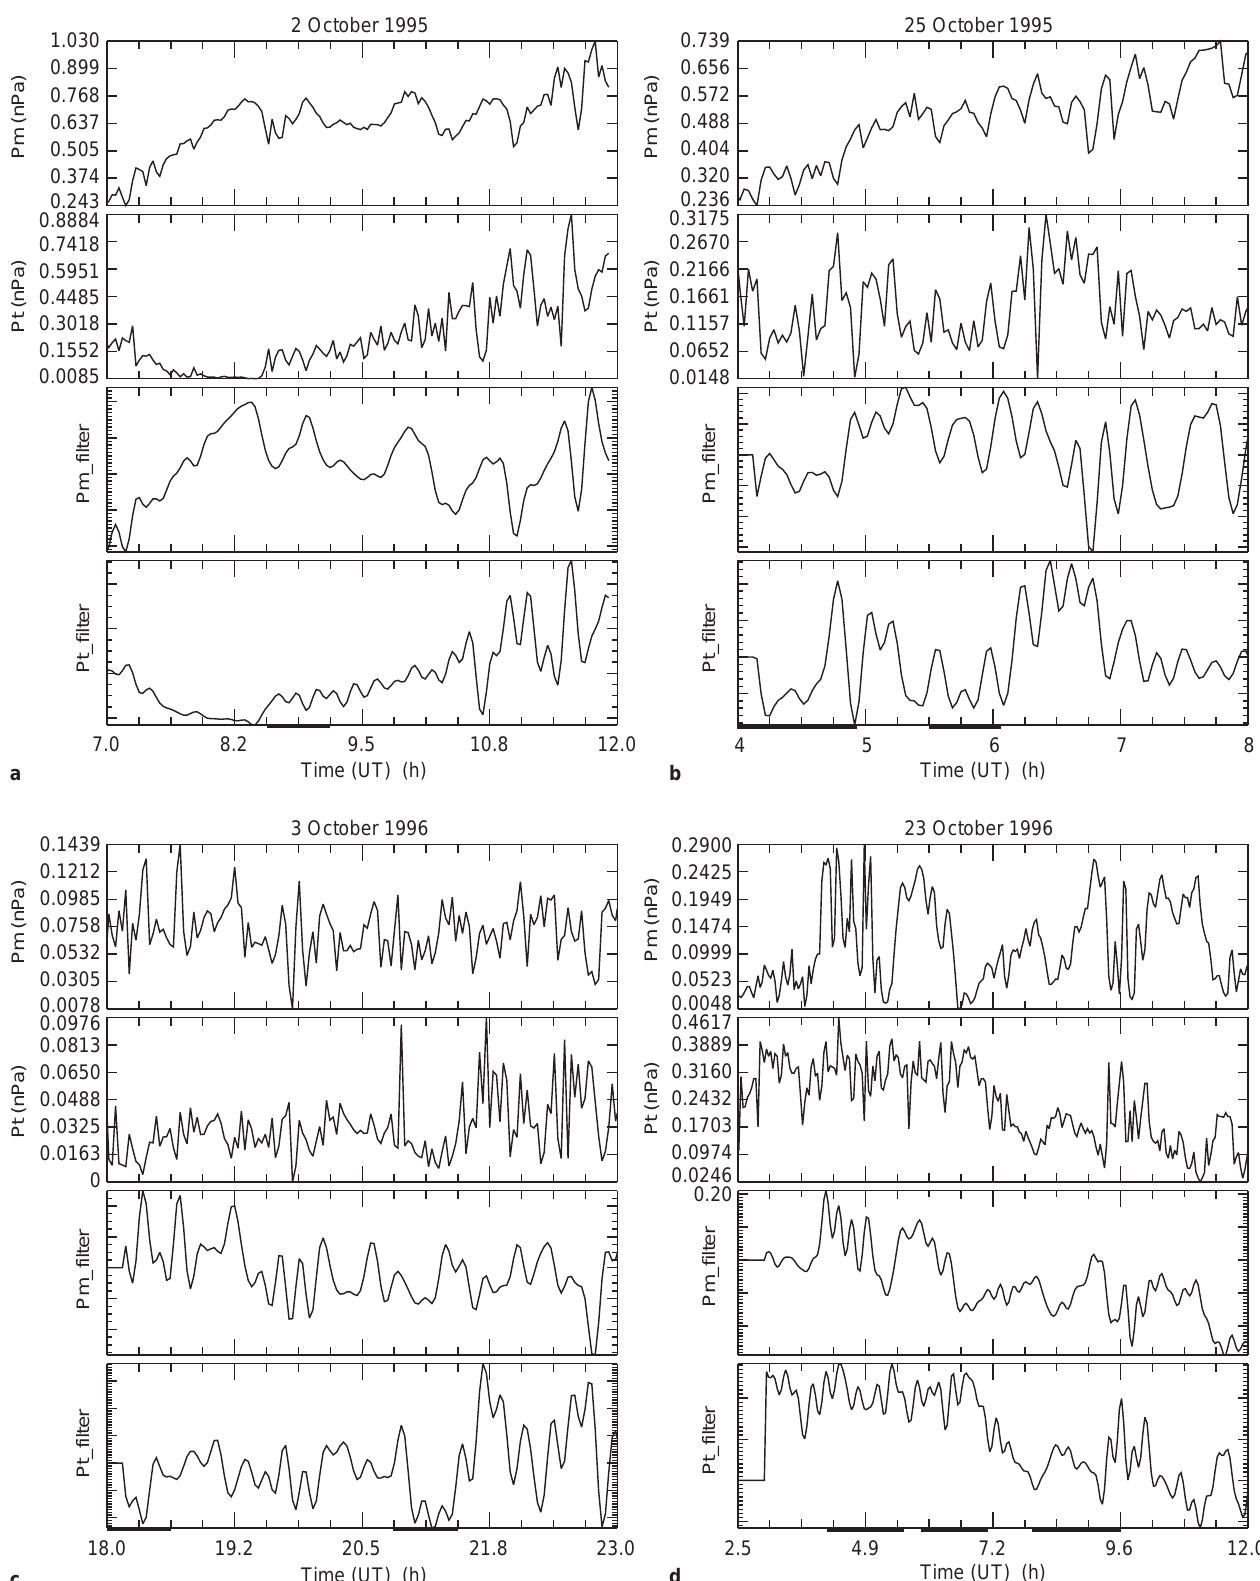
Fig. 2a–d. Magnetic pressure and plasma pressure ( upper panels ) are presented for the time intervals: a from 07:00 UT to 12:00 UT 2 October 1995; b from 04:00 UT to 8:00 UT 25 October 1995; c from digital filter are shown in the lower